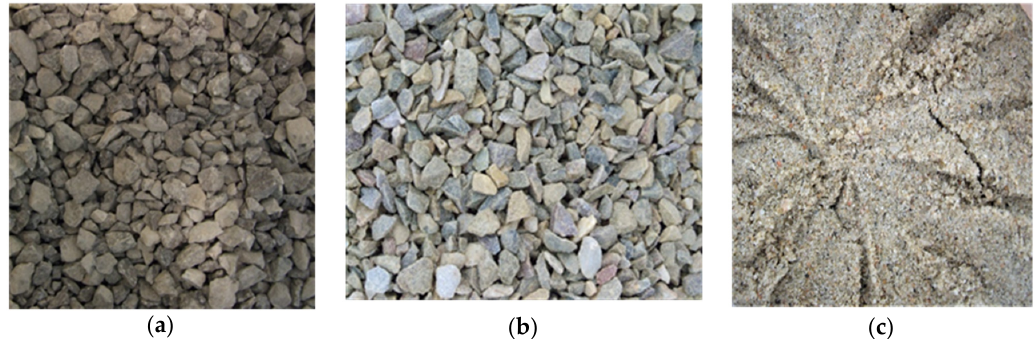
Figure 1. Siliceous aggregates employed in the present research work: ( a ) ASJ_12 (siliceous pebbles, 4–6 mm); ( b ) VB_1 (siliceous gravel, 6–12 mm); ( c ) ASJ_2 (siliceous sand, 0–2 mm).